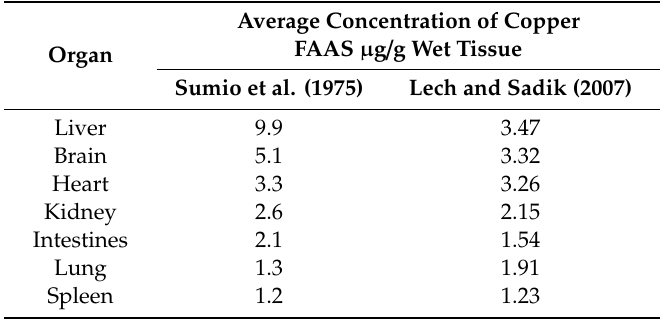
Table 1. Average concentration of copper in human organs (according to